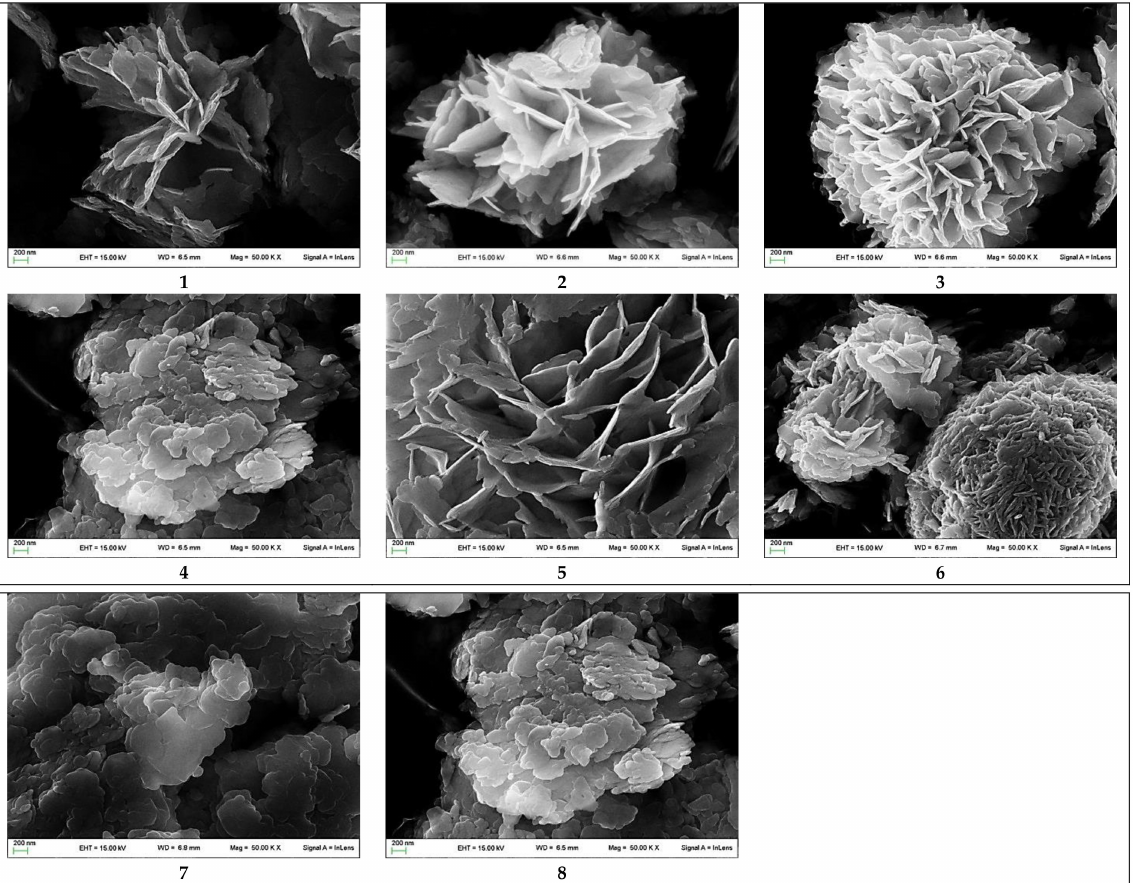
Figure 2. FE-SEM images of samples 1–8 at Mag 50.00